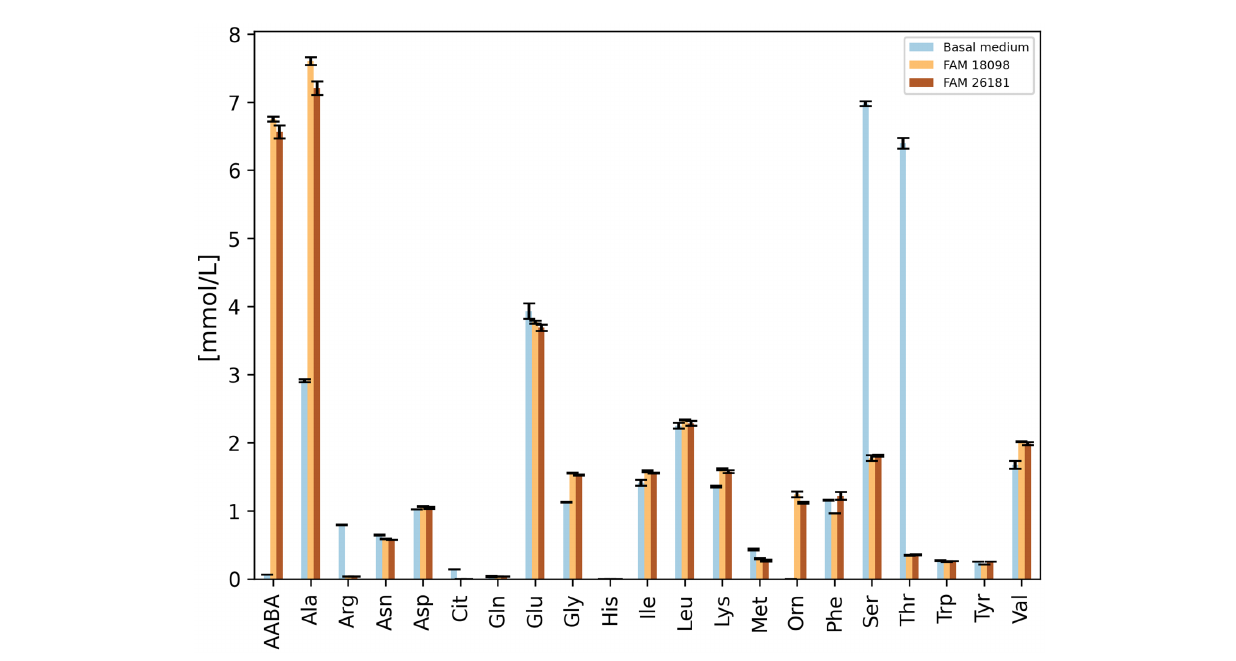
FIGURE 3 Amino acid concentrations in culture supernatants of wild-type strain FAM 18098 and aat knockout strain FAM 26181 after incubation for 4 days in the basal medium. Values represent the mean (±standard deviation) of two independent biological experiments. AABA: α -aminobutyric acid, Cit: citrulline, Orn: ornithine. All other amino acids are abbreviated according to IUPAC nomenclature.